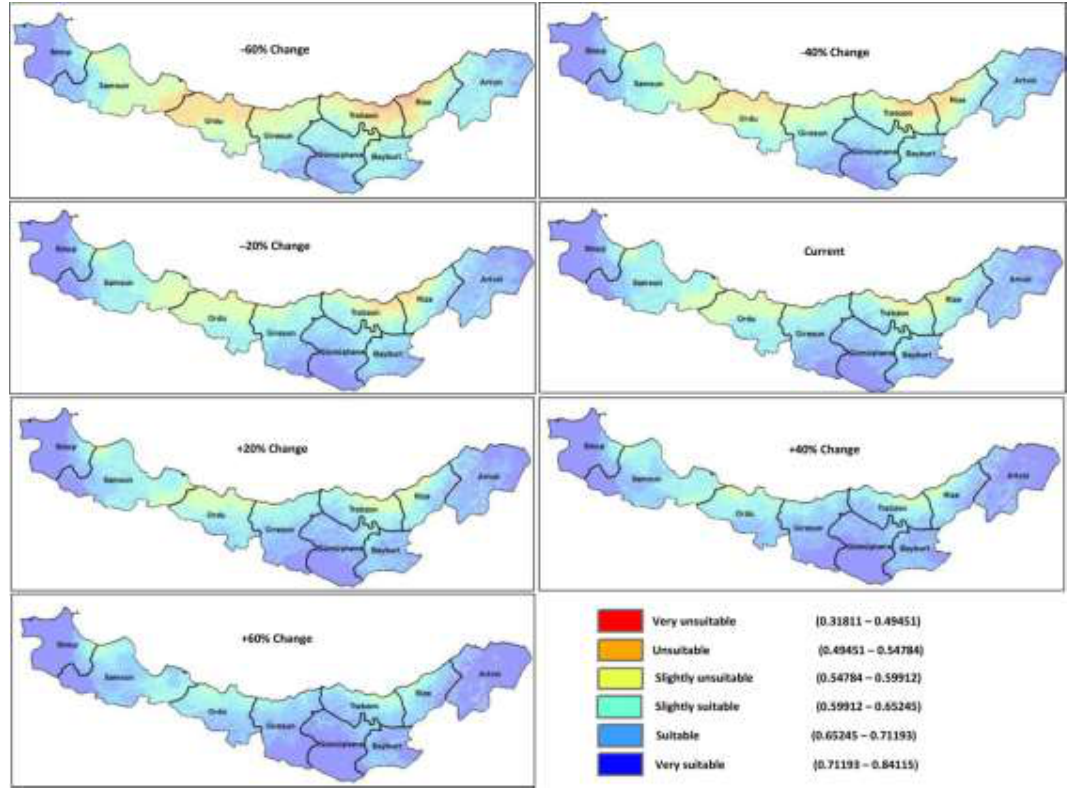
Figure 10. Conformity Map of Ecotourism Areas (Source: Çetinkaya et al.,